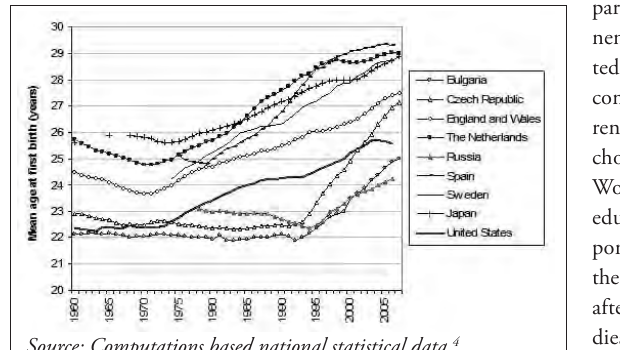
Source: Computations based national statistical data. Figure 1: Mean age of mother at birth of first child, selected countries of Europe, Japan and the United States (1960-2007).